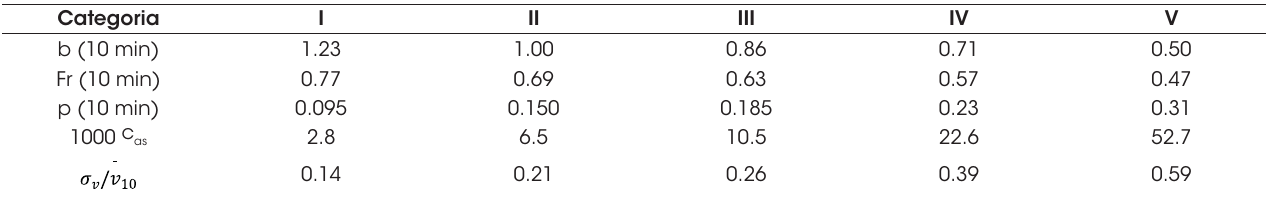
Parameters characteristic of the natural wind and roughness of the terrain